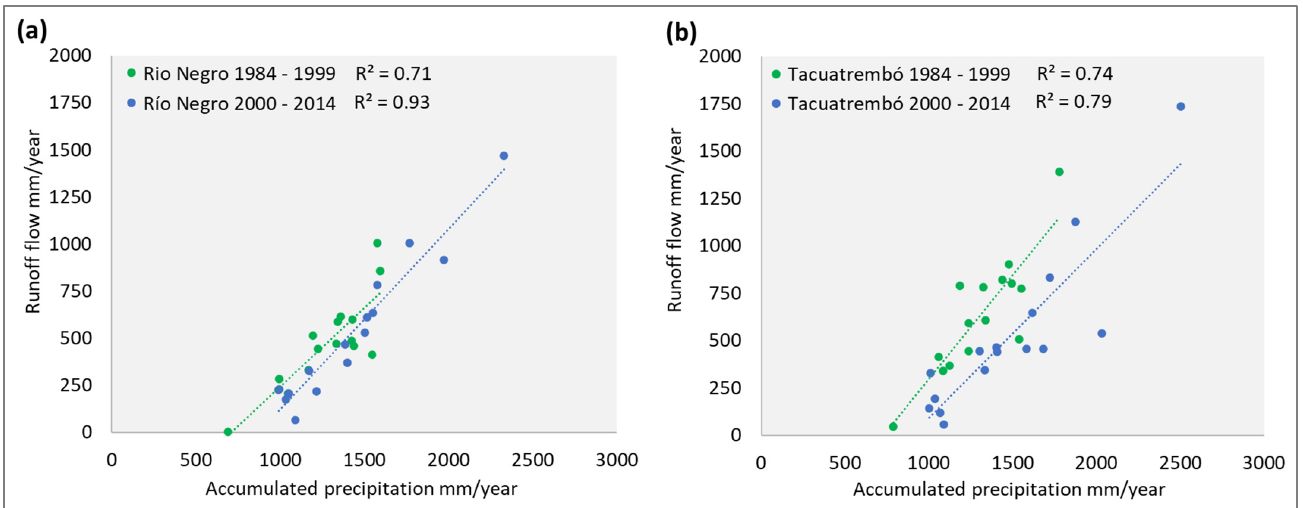
Figure 9. Correlation analysis between surface runoff and annual accumulated precipitation of the Río Negro basin ( a ) and the Tacuarembó basin ( b ) for the periods 1984–1999 (green dots) and 2000–2014 (blue dots).